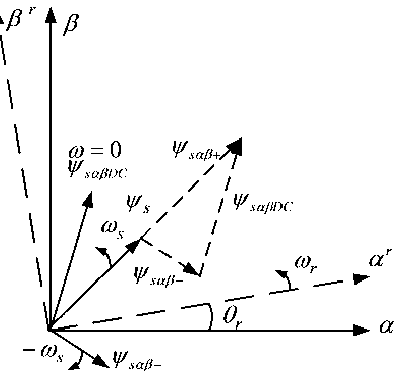
Figure 2. Spatial relationships between the stationary αβ reference frame and the rotor α r β r reference